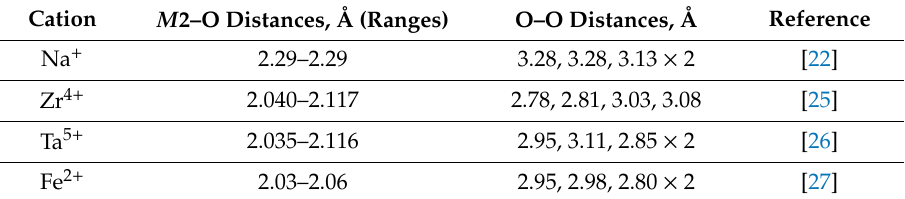
Table 1. Geometric parameters of the M 2O 4 polyhedra for di ff erent cations.